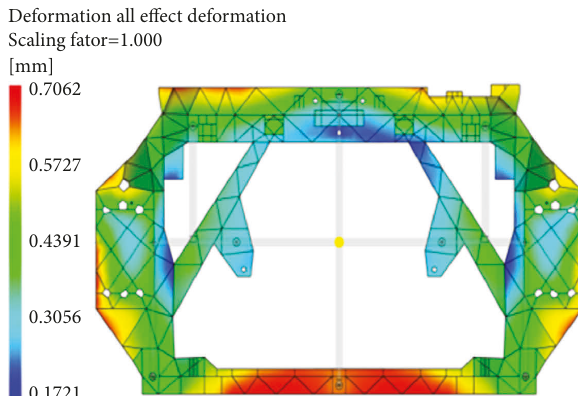
Figure 29: Cloud image of